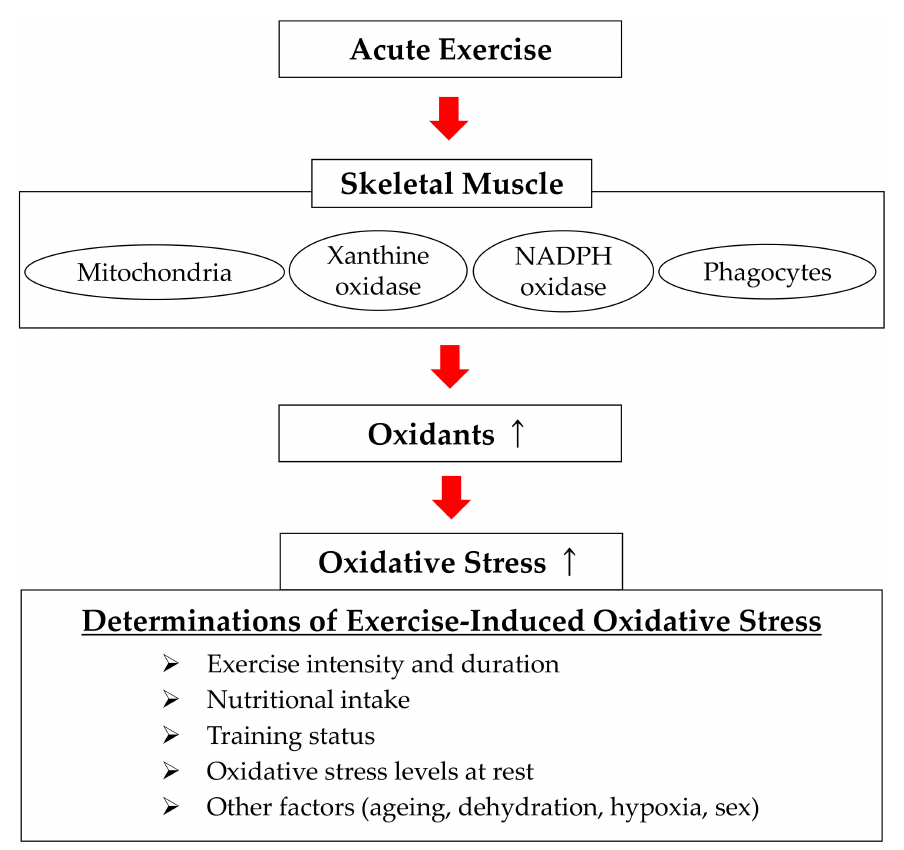
Figure 2. Determinants of exercise-induced oxidative stress and sources of free radical production. NADPH: nicotinamide adenine dinucleotide